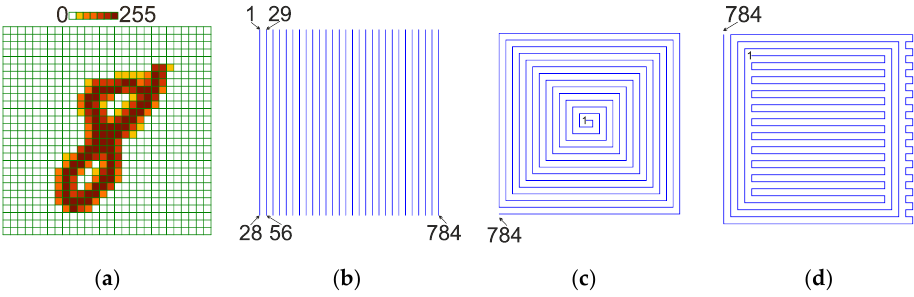
Figure 1. An example of a 28 × 28 pixel image of the handwritten digit “8” from the MNIST-10 database ( a ). Patterns for transforming the image array: T-pattern-1 ( b ), T-pattern-2 ( c ), T-pattern-3 ( d ). T-pattern-1 performs column-by-column input of the image; T-pattern-2 converts the image in a spiral (clockwise) form; and T-pattern-3 is a combination of line-by-line input of the central part of